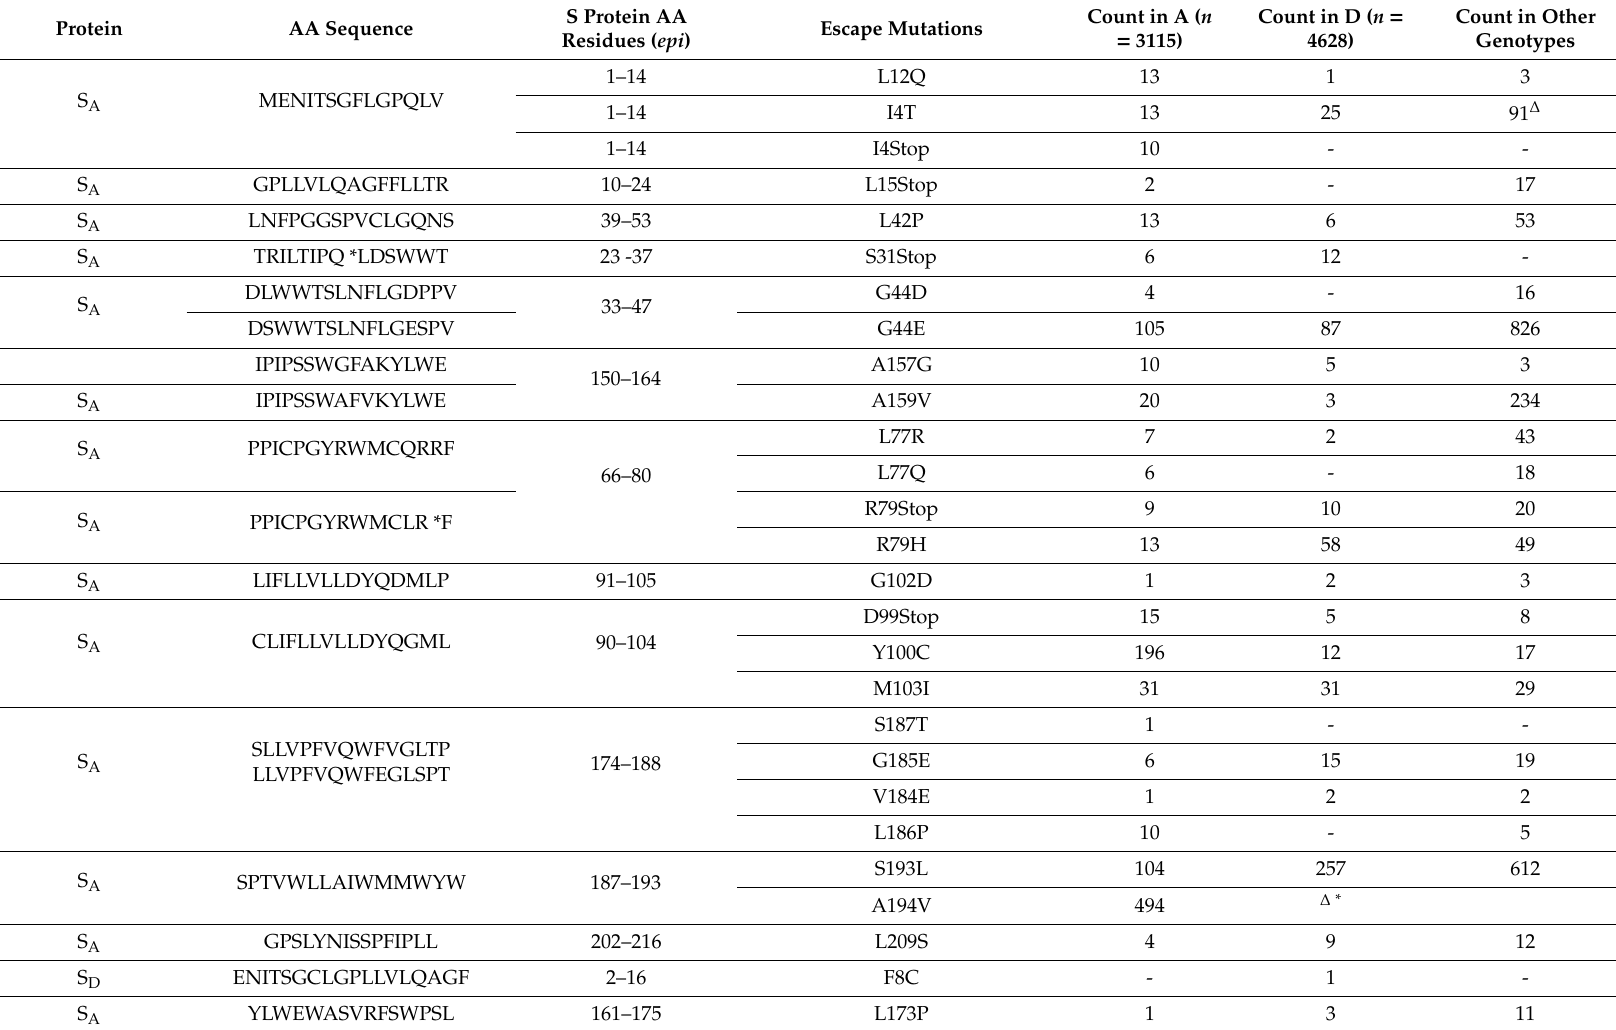
Table 5. The prevalence of S gene escape